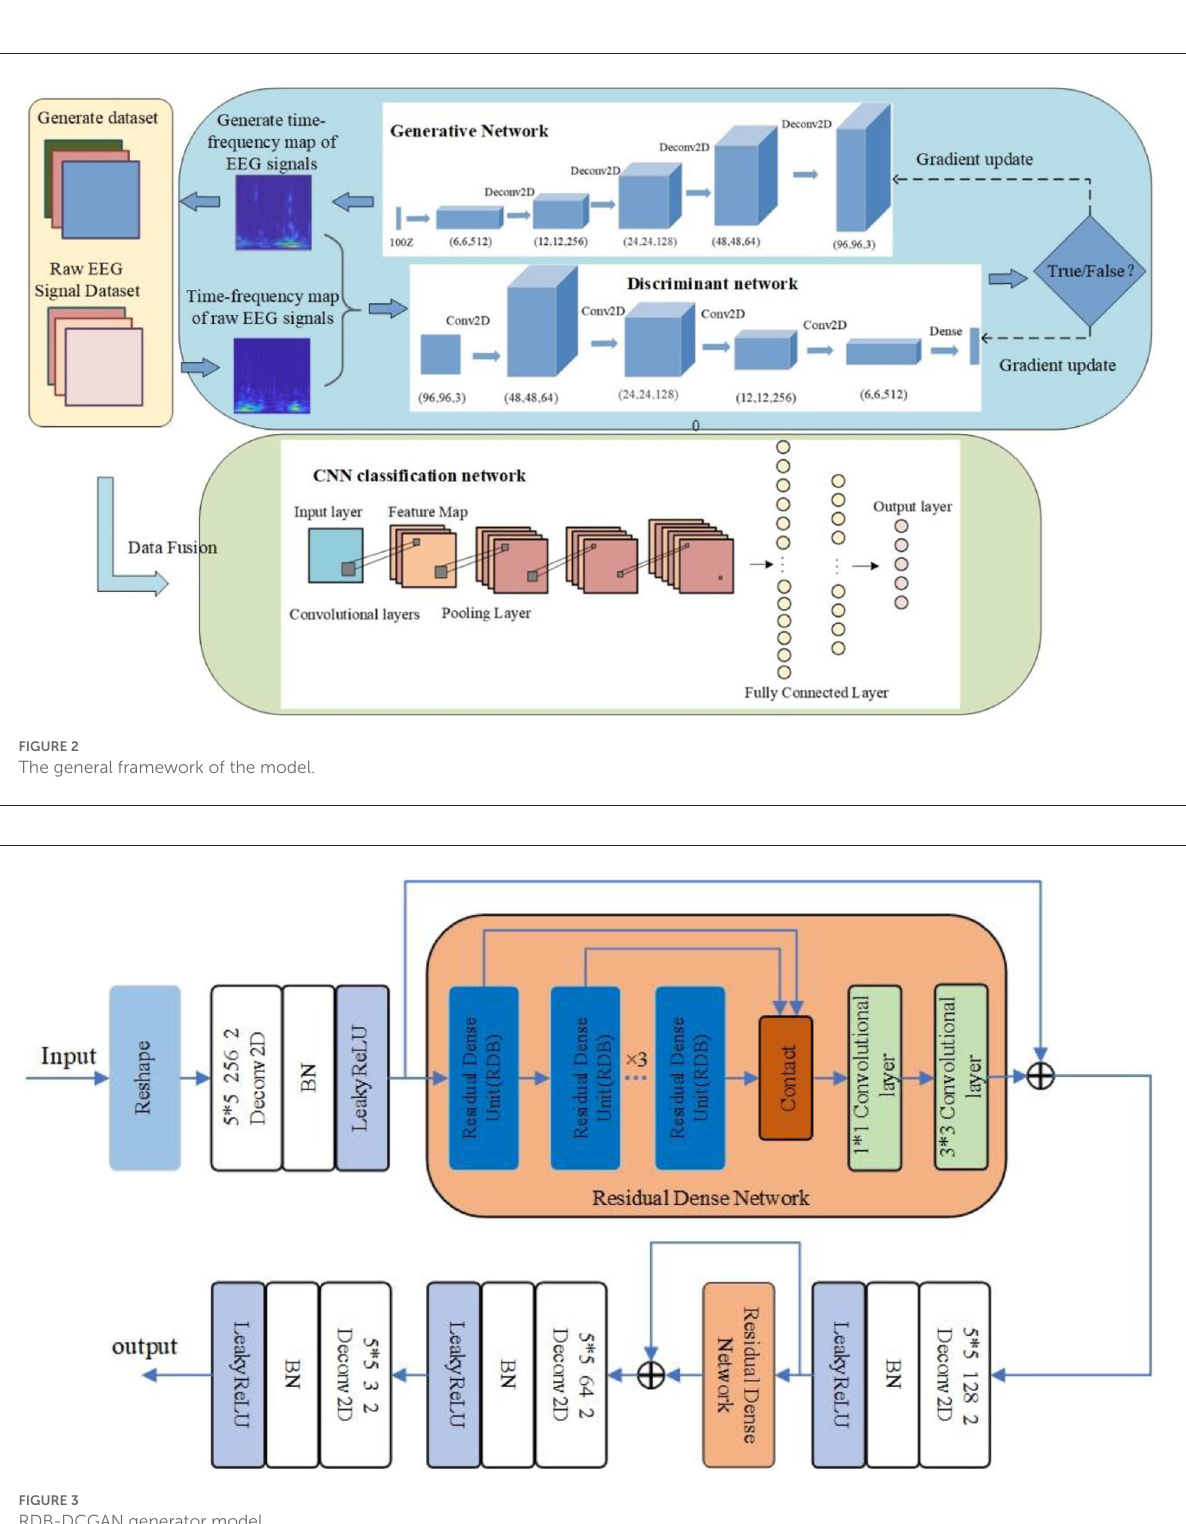
FIGURE3 RDB-DCGAN generator